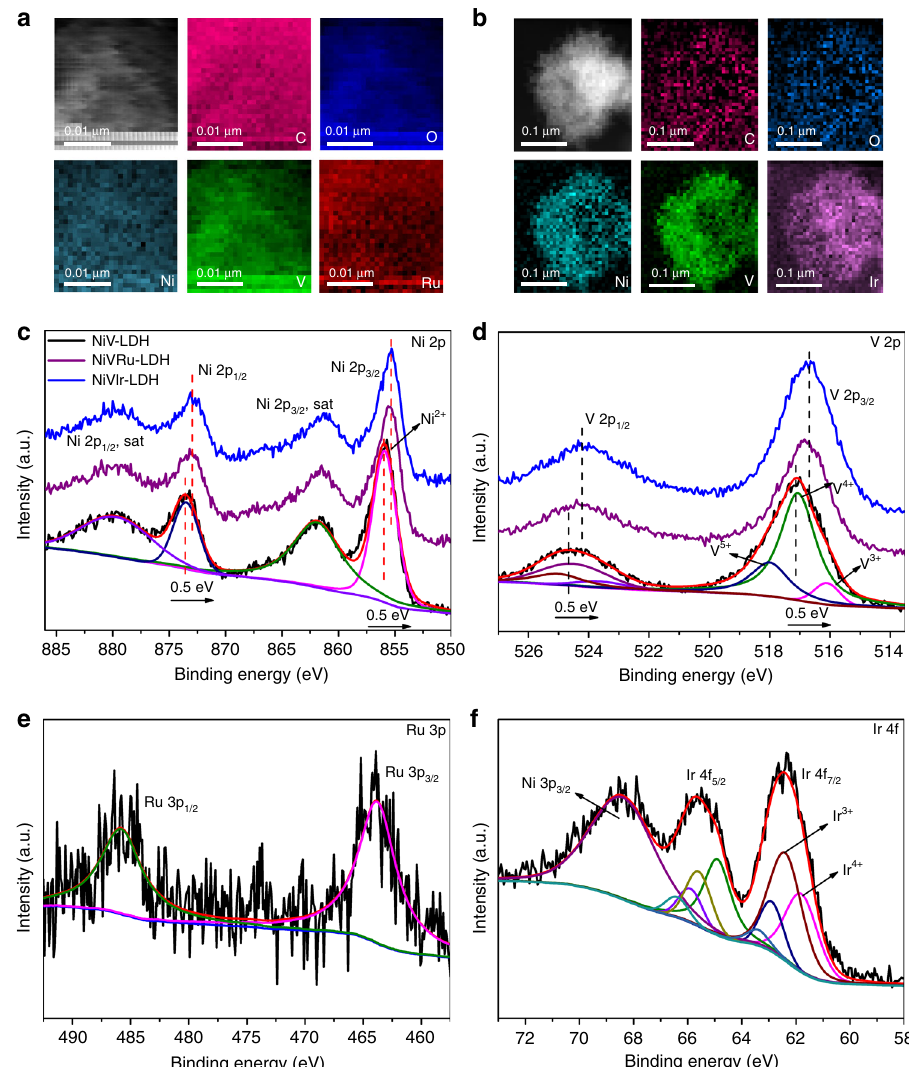
Fig. 2 HAADF-STEM images and XPS spectra. HAADF-STEM images of a NiVRu-LDH and b NiVIr-LDH, and the corresponding EELS mappings images. The high-resolution XPS signals of NiV-LDH, NiVRu-LDH, and NiVIr-LDH for c Ni 2p and d V 2p. The high-resolution XPS signals of Ru 3p in e NiVRu-LDH and f Ir 4 f in